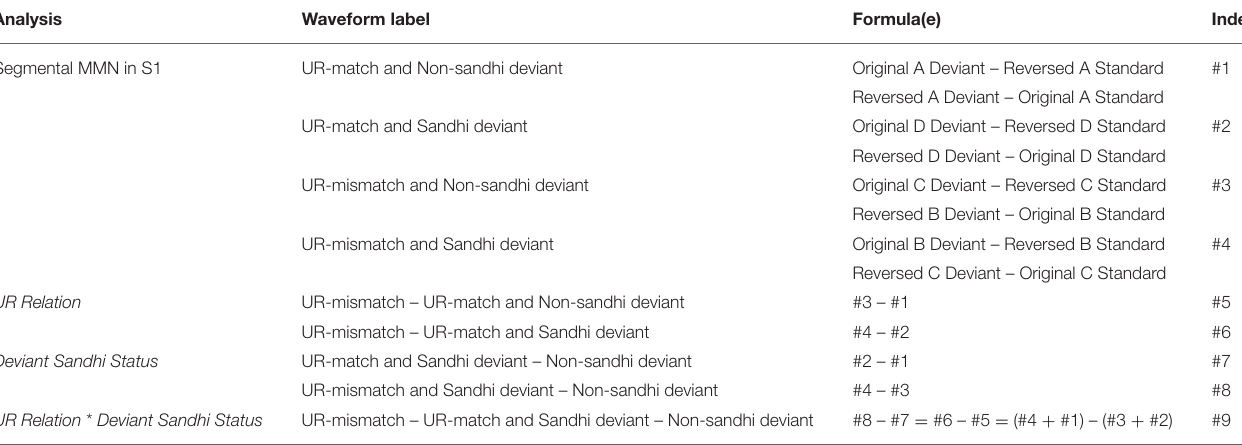
TABLE 4 | A summary of the formula(e) for isolating difference